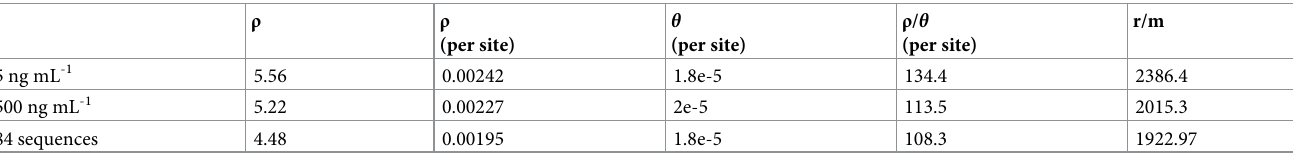
Table 2. S . pneumoniae transformation experiment